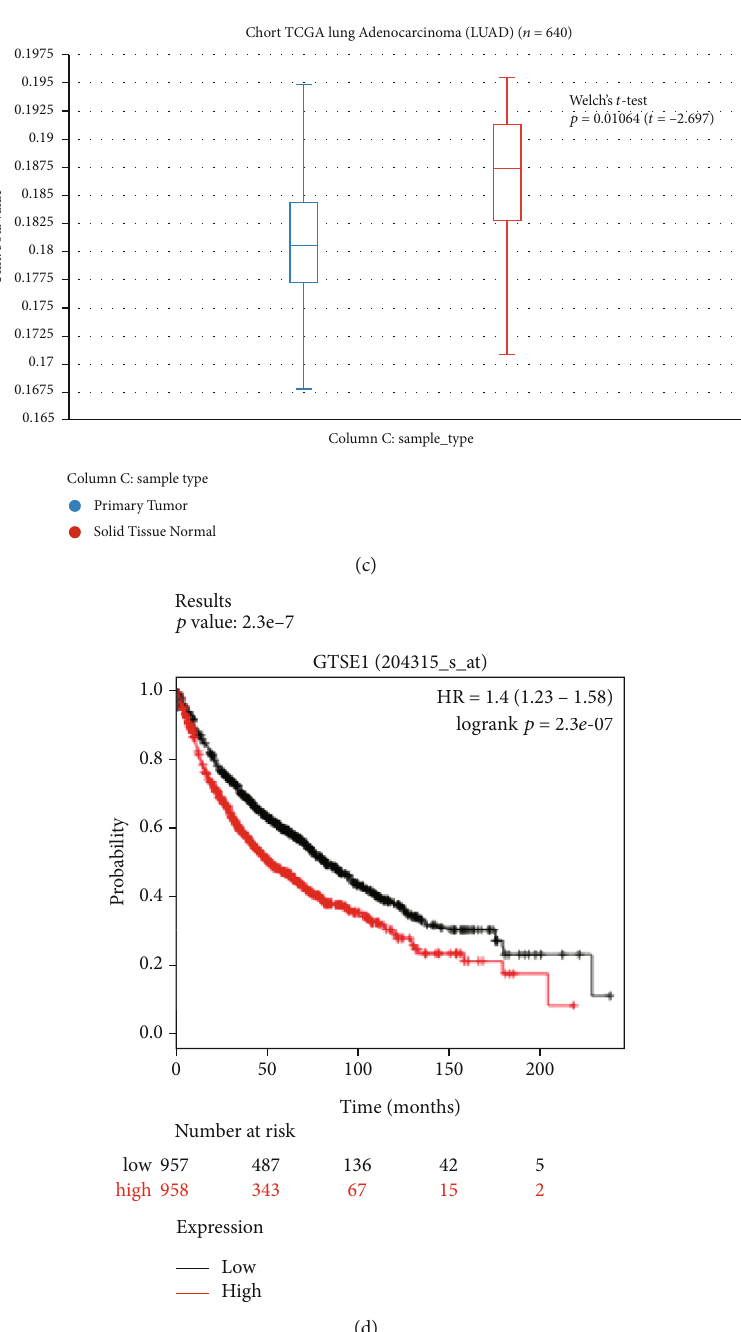
Figure 1: The prognostic role of GTSE1 expression in lung cancer. (a) The mRNA levels of GTSE1 in squamous cell lung carcinoma and lung adenocarcinoma were higher than those in lung normal tissues. (b) TCGA database revealed the GTSE1 expression in lung tumor samples and normal lung samples. (c) TCGA database revealed that the methylation level of the GTSE1 promoter was signi fi cantly decreased. (d) The Kaplan-Meier plotter analysis database revealed the overall survival of patients with lung cancer with high or low GTSE1